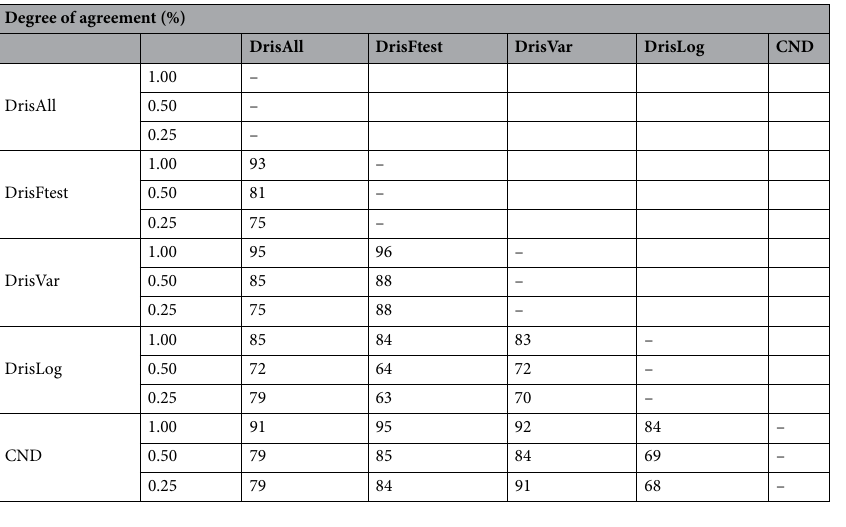
Table 2. Parity grade (PG) obtained between the diagnoses of the DRIS and CND methods adopting different range factors adopted in the nutrient responsiveness range (NRr) for the diagnosis of B in soybean, cultivated in Chapadão do Sul, Mato Grosso do Sul, Brazil. DRIS method adopting the criteria of selecting all bivariate relations—DrisAll, using the criterion Ratio of Variances—DrisVar, using the F test—DrisFtest and using the logarithmic transformation—DrisLog and compositional nutrient diagnosis—CND.